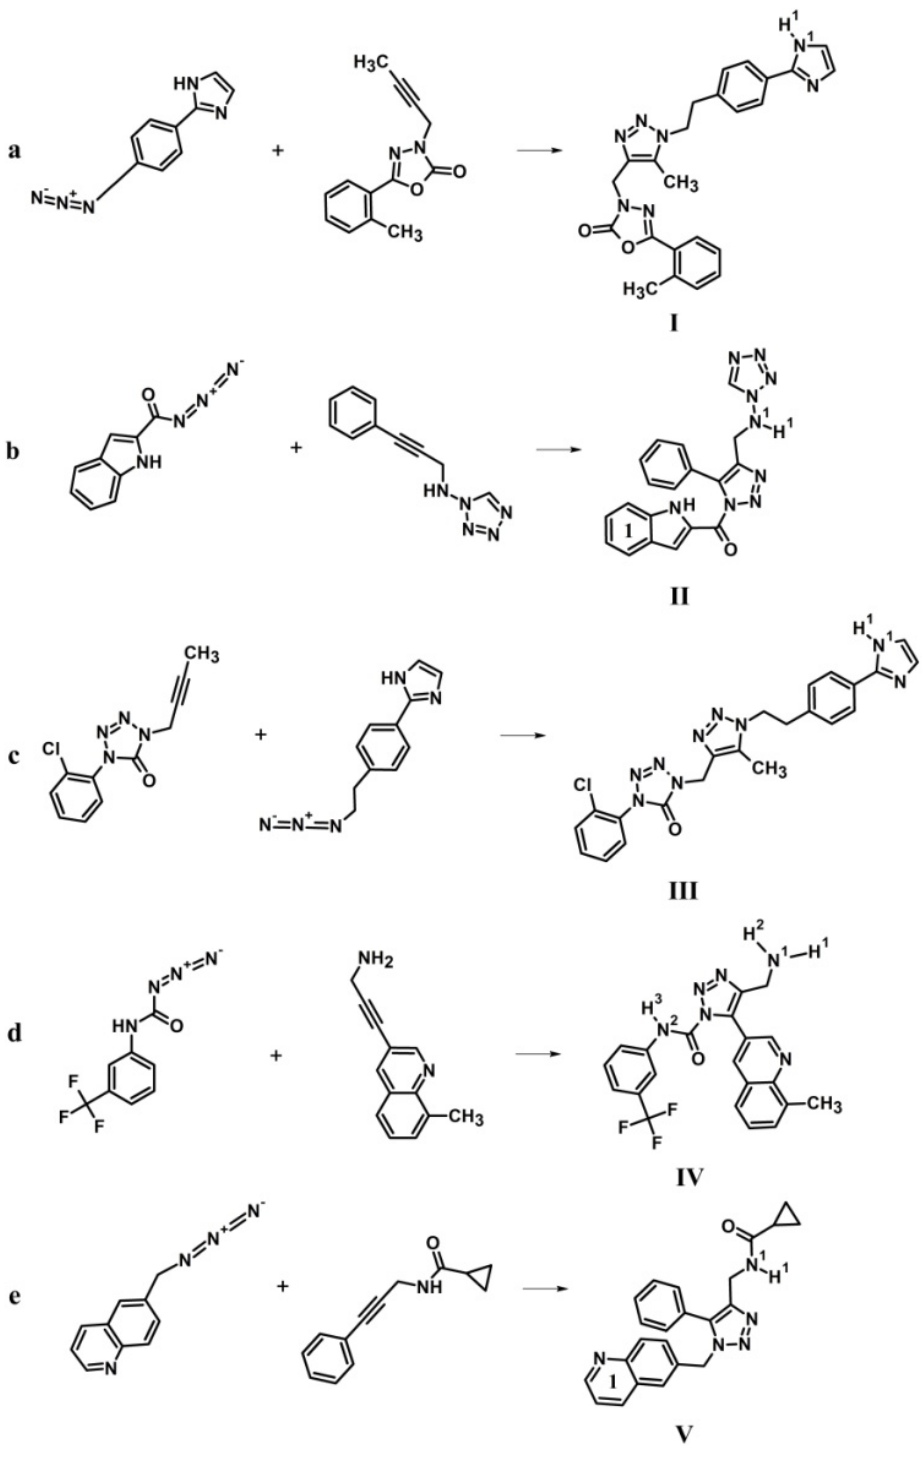
Figure 4. Computer-aided assembly of hybrid molecules I ( a ), II ( b ), III ( c ), IV ( d ), V ( e ) that were identified as the most promising CD4-mimetic candidates. The reagents and products of the reaction of azide-alkyne cycloaddition are shown. Functional groups of the designed molecules forming hydrogen bonds and salt bridges with gp120 are indicated using superscripts (Table 2). The aromatic rings involved in the T-shaped-interactions with Trp-427 gp120 are numbered (Table 2). Insights into the PM7-based ligand / gp120 complexes show (Figure 5) that all the selected molecules mimic the key interactions of Phe-43 and Arg-59 of CD4 with the Phe-43 cavity of gp120 and residue Asp-368 gp120 located within the vestibule of this hydrophobic pocket [16]. It is known that these interactions greatly contribute to the attachment of HIV-1 to a target cell [16]. This is also confirmed